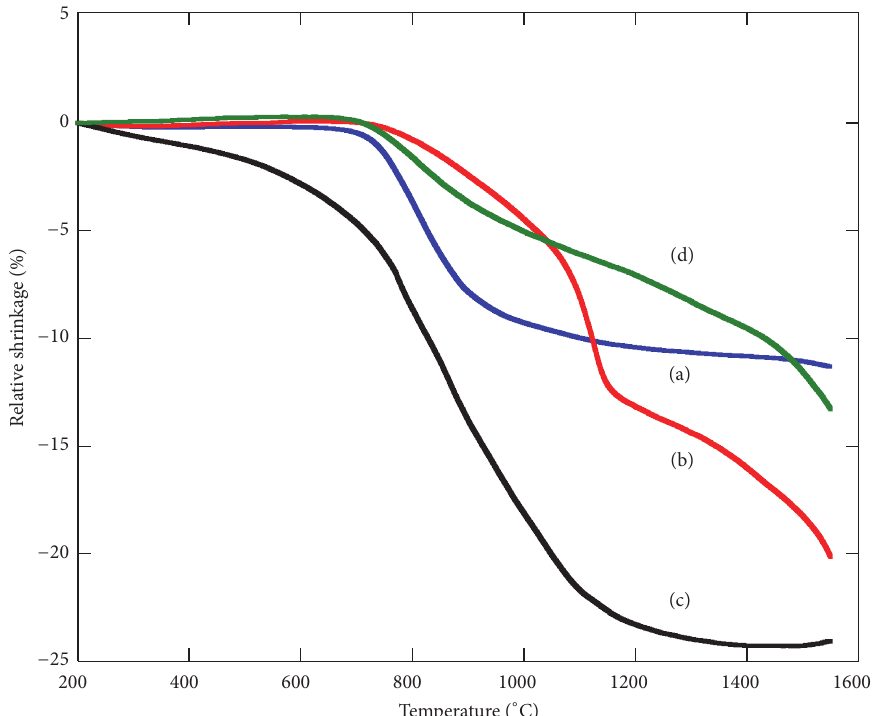
Figure 7: Linear shrinkage upon sintering for N-SDC20 (a), T-SDC20 (b), C-SDC20 (c), and U-SDC20 (d) powder.